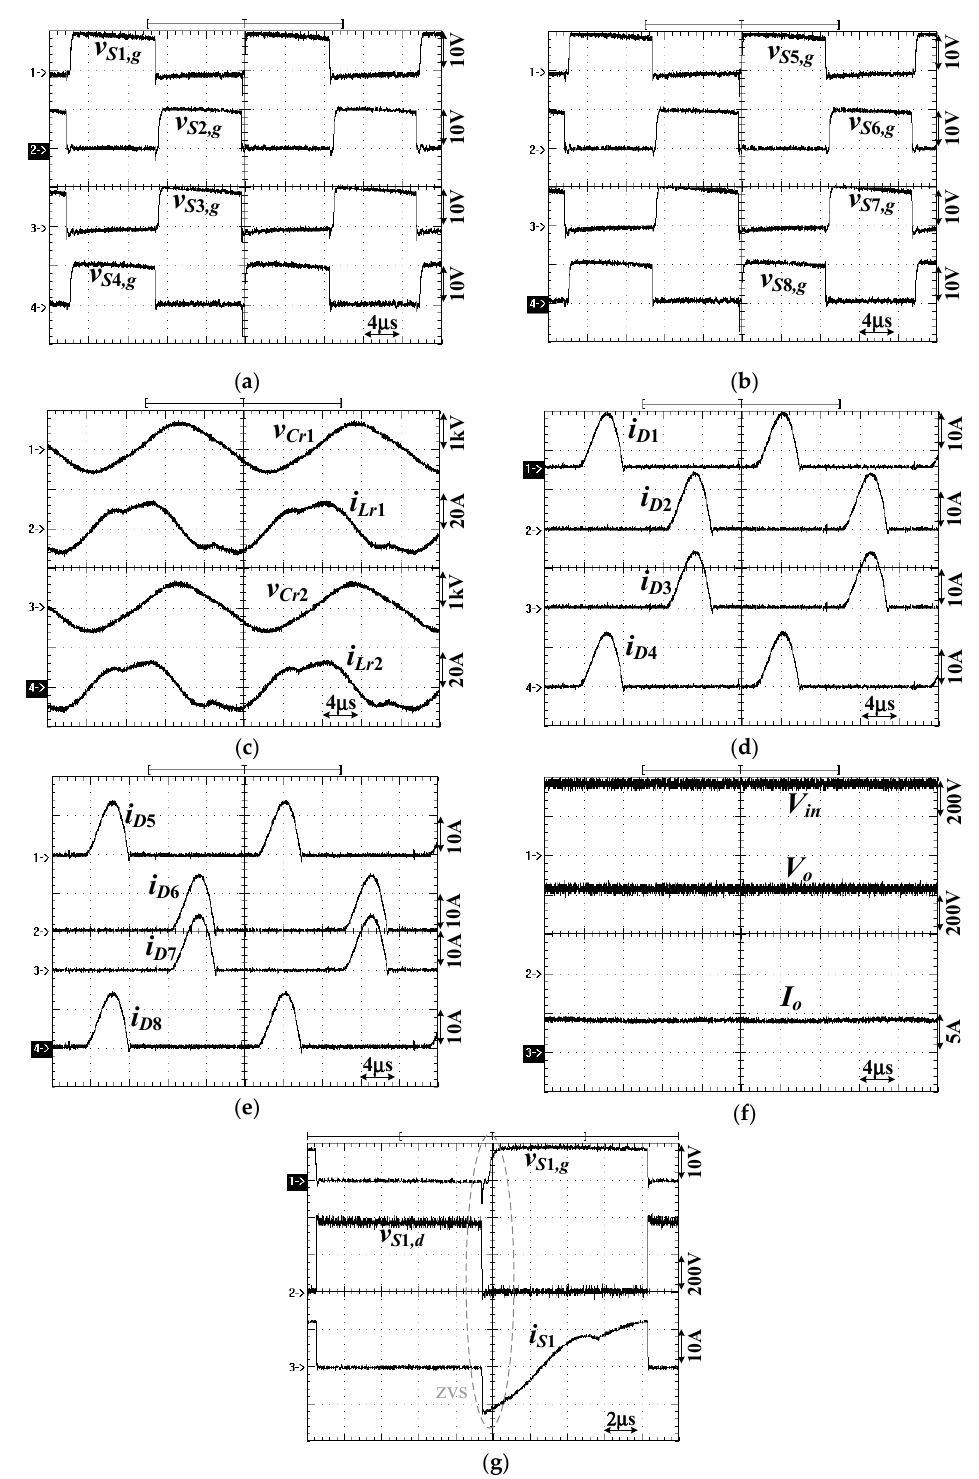
Figure 10. Measured results at 440 V output and 2 kW load under a high output voltage range. ( a ) PWM signals v S 1, g ~ v S 4, g ; ( b ) PWM signals v S 5, g ~ v S 8, g ( c ) v Cr 1 , i Lr 1 , v Cr 2 , i Lr 2 ; ( d ) diode currents i D 1 ~ i D 4 ; ( e )